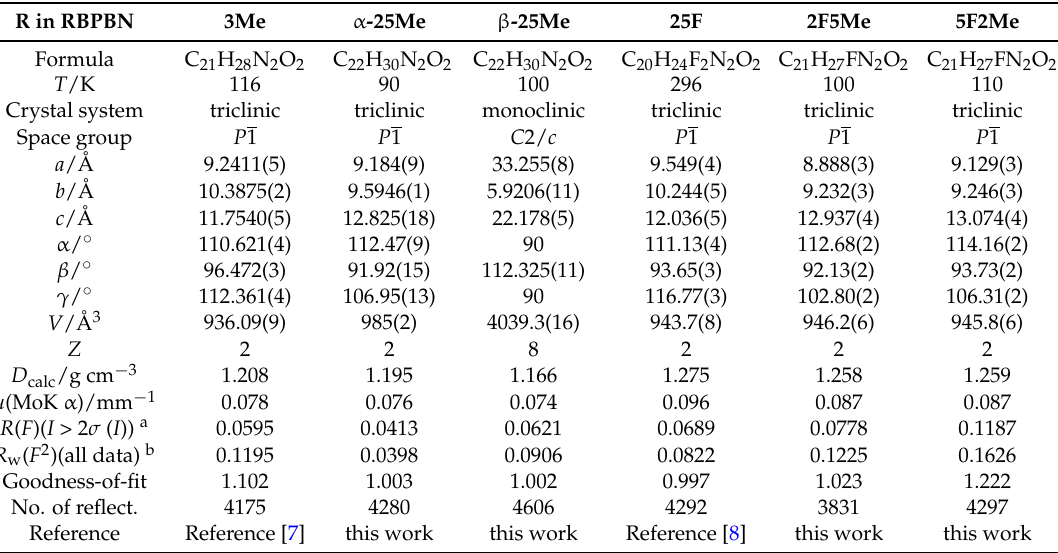
Table 1. Selected crystallographic data for BPBN derivatives.